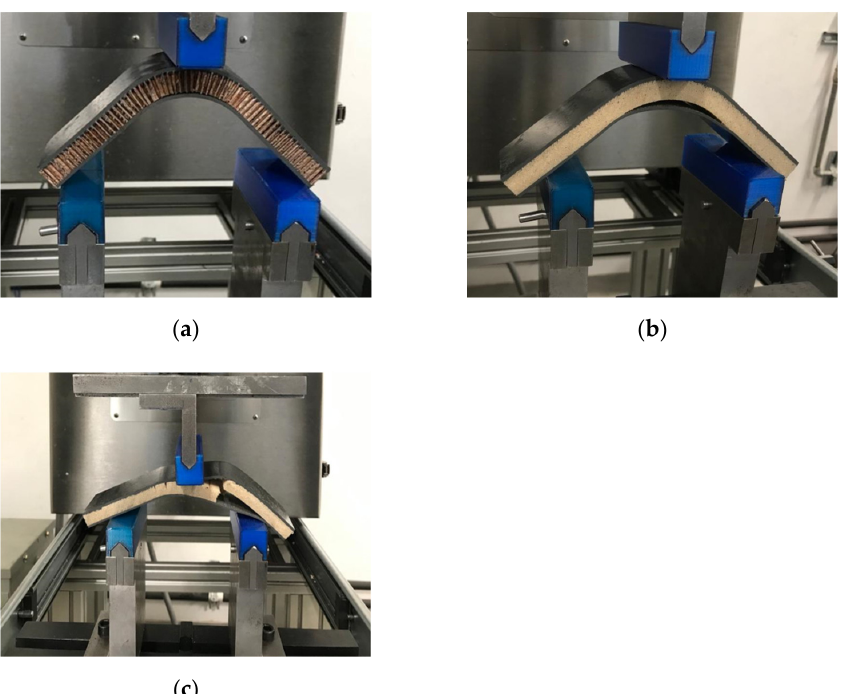
Figure 11. Pictures of the three ‐ point bending test performed to ( a ) ABS/HC/ABS, ( b ) ABS/Foam/ABS,